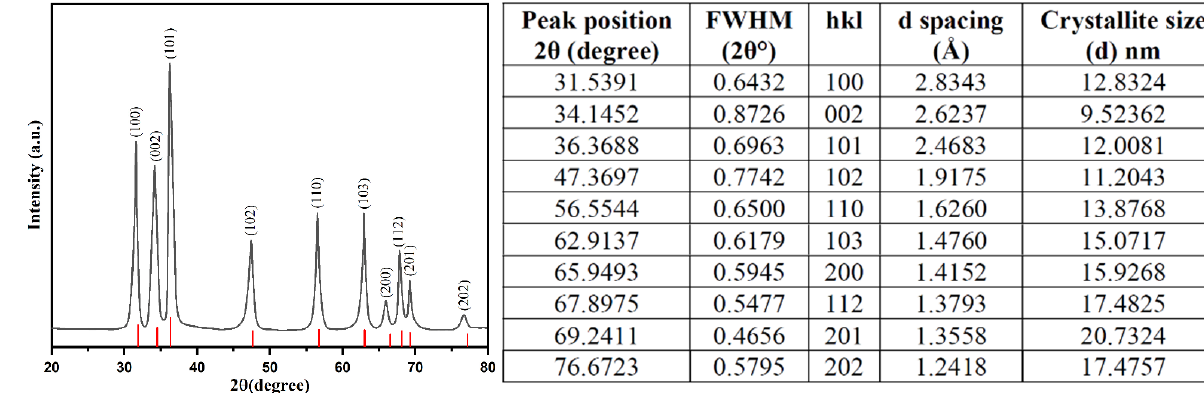
Figure 4. XRD pattern for the bio ‐ fabricated ZnONPs, including X ‐ ray diffraction data and particle size analysis.